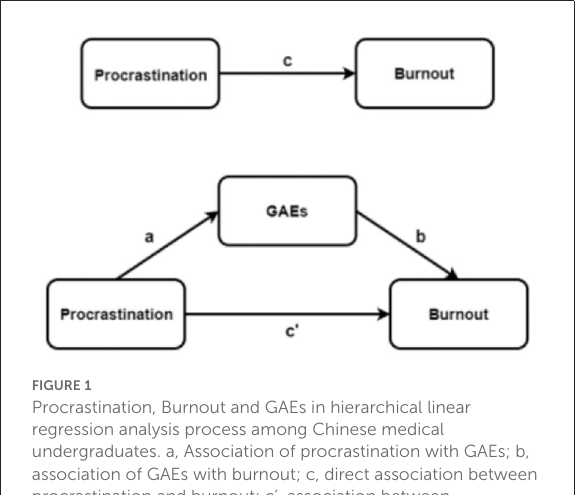
FIGURE1 Procrastination, Burnout and GAEs in hierarchical linear regression analysis process among Chinese medical undergraduates. a, Association of procrastination with GAEs; b, association of GAEs with burnout; c, direct association between procrastination and burnout; c’, association between procrastination and burnout with GAEs as mediators.